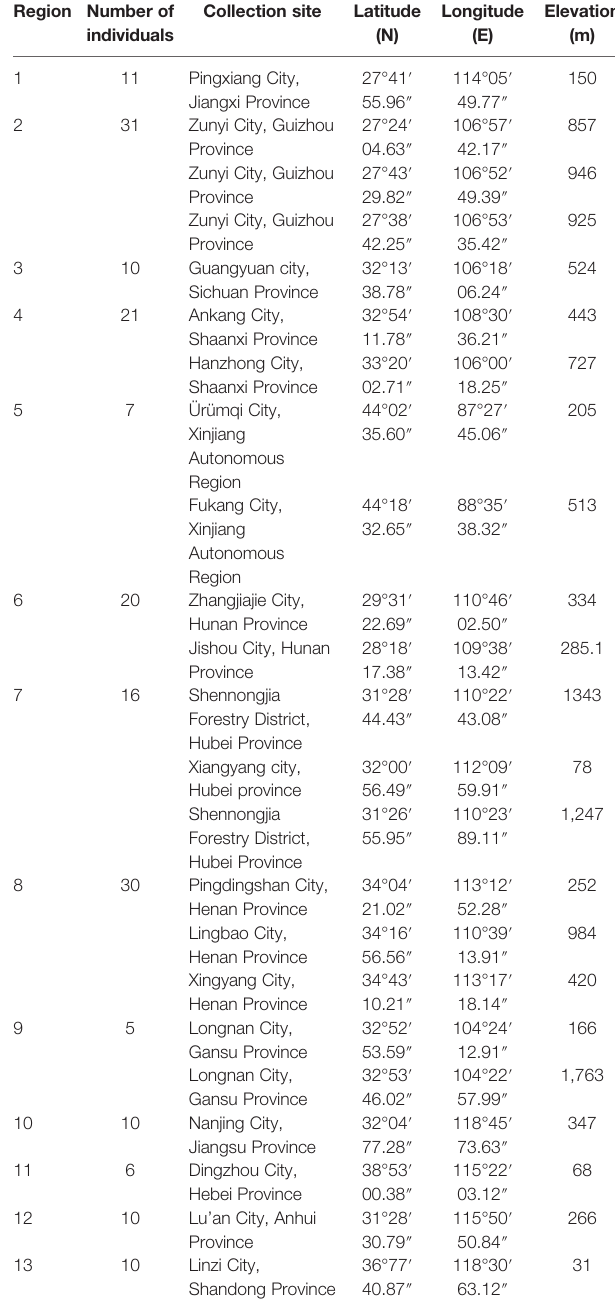
TABLE 1 | Information of the leaves (EUL)